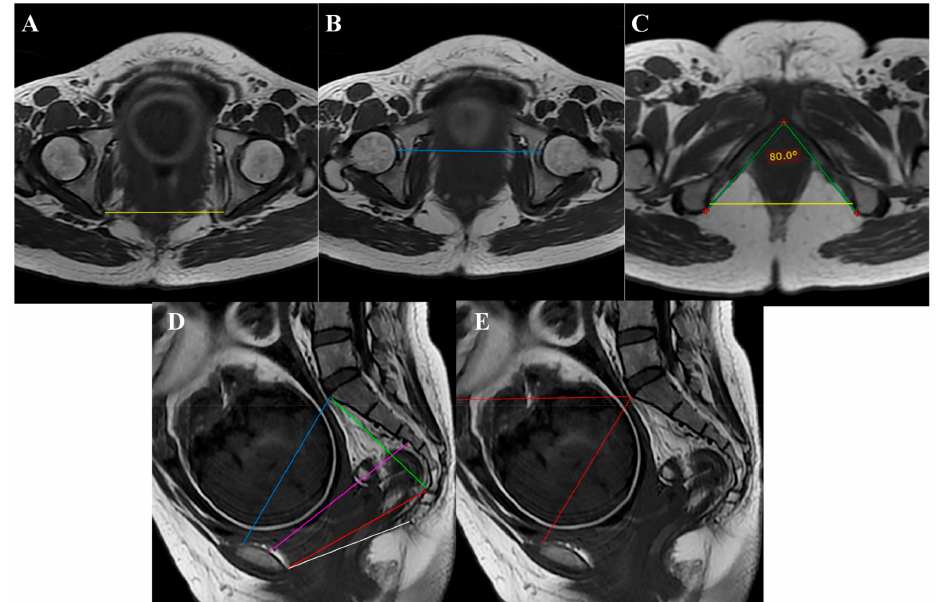
Figure 2. MRI pelvimetry: ( A ) Intertuberous distance; ( B ) Bilateral femoral head distance; ( C ) Pubic angle (green line) and interspinous distance (yellow line); ( D ) Obstetric conjugate (blue line), pelvic width (purple line), sacral outlet diameter (red line), outlet diameter of the pelvis (white line), and sacral length (green line); ( E ) Pelvic inclination (red